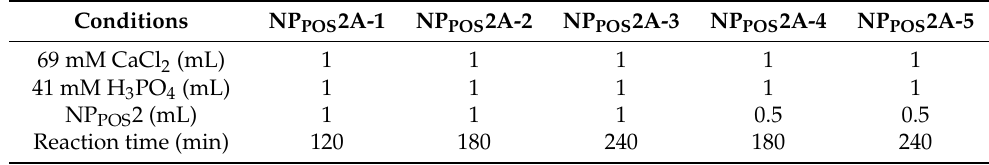
Table 2. Operating conditions employed in the method A of CaP